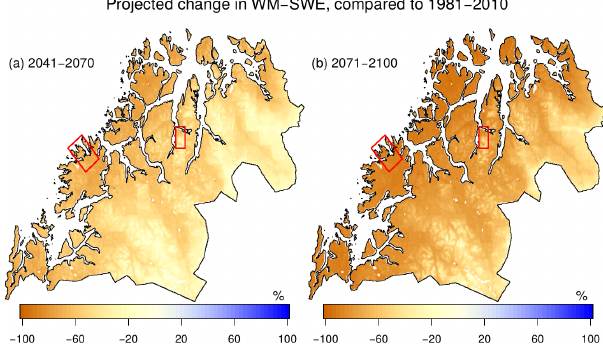
Figure 5. Projected change in maximum snow water equivalent (SWE) during winter (October–April) between 1981–2010 and (a) the near future (2041–2070) and between 1981–2010 and (b) the far future